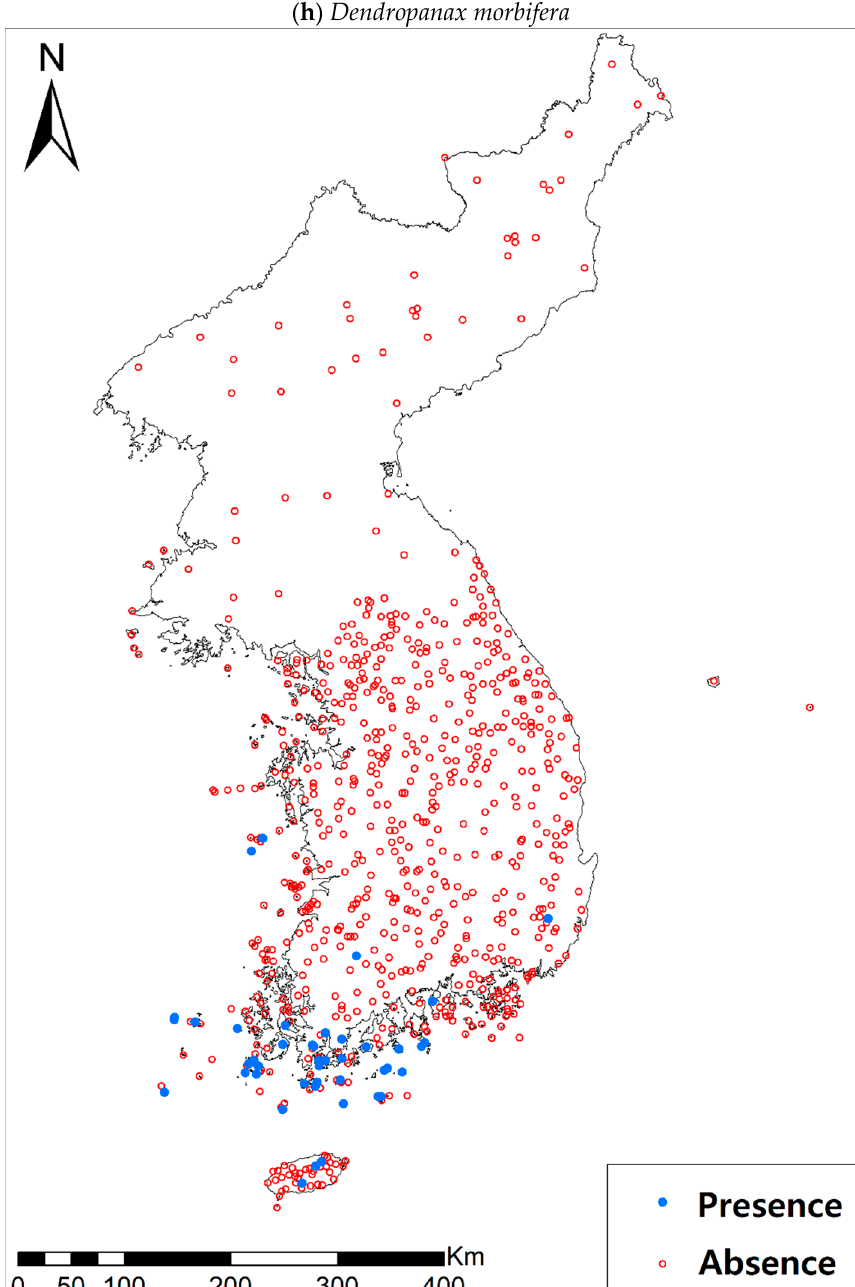
Figure A1. Presence/absence maps for the eight study species. For political reasons, we had no access to 52 sites in DPRK. Obviously, such spatially uneven samples and the lack of DPRK data could have negatively influenced the ability of SDM predictions [34]. However, we consider that it should not be a critical issue for modelling the climatically suitable habitats of eight coastal plants due to the lack of possibility that those species naturally occur in DPRK. Those species have been distributed in the southern coastal areas and showed a strong preference for warm and humid habitat conditions [42,97]. Therefore, colder and drier inland climate of DPRK could not account for the climatic niches of those plants. In addition, the 52 sites of DPRK represent the alpine and subalpine areas that are not found in ROK. Therefore, including those DPRK data are helpful in terms of considering the full range of the KP climatic conditions in modelling current and future distributions of the eight evergreens on the KP.